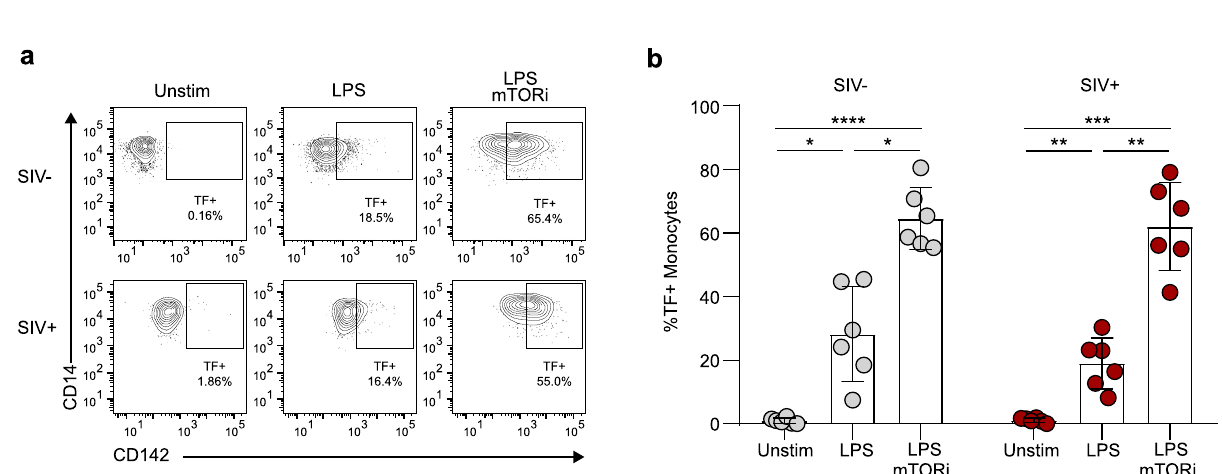
Fig. 5 mTOR inhibition potentiates surface expression of tissue factor on monocytes from uninfected and SIV-infected macaques in an equivalent manner. a , b Cryopreserved PBMCs from six uninfected and six chronically SIVmac239-infected rhesus macaques were pretreated with an mTORi (AZD2014 at 5 μ M, 6 h) or DMSO and stimulated with LPS (1 ng, 12 h) prior to staining for fl ow cytometry. For b , gray dots represent uninfected (SIV − ) animals and red dots represent infected (SIV + ). Representative fl ow plots ( a ) and aggregate ( b ) represent gating on leukocyte/singlet/live/CD11b + /CD14 + . For additional details on gating strategy see Supplementary Fig. 6. * p < 0.05, ** p < 0.01, *** p < 0.001, **** p < 0.0001, p values calculated using a two-way ANOVA and Sidak ’ s multiple comparisons. Error bars represent mean ±